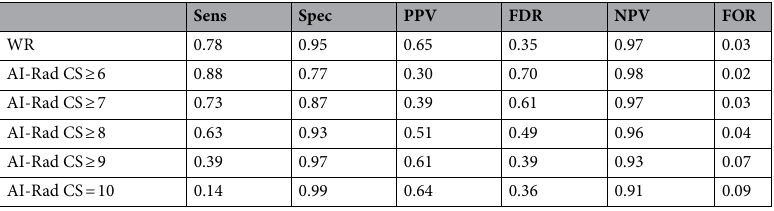
Table 4. Performance metrics of the radiologists (WR = written report) and the AI Rad Companion Chest X-ray (AI-Rad) for the detection of consolidations. CS confidence score, PPV positive predictive value, NPV negative predictive value, FDR false discovery rate, FOR false omission